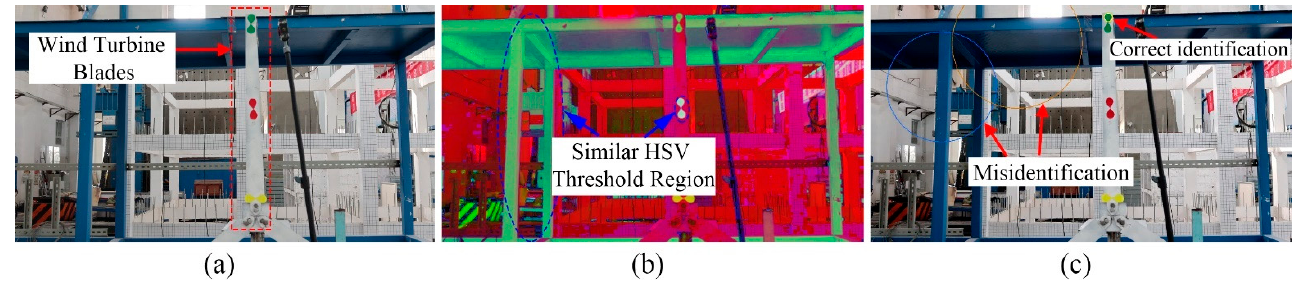
Figure 16. Monitoring effect of optical flow method in a complex background situation: ( a ) Harris corner matching in ROI area; ( b ) actual monitoring effect of optical flow method in ROI area. Figure 14 shows the performance of the three algorithms in the tracking process under the condition of illumination change. When the illumination changes, the prede- termined threshold of the monitoring points exceeds the range, and the color matching algorithm cannot capture the target points. Figure 14a shows the tracking situation of the color matching algorithm at different frame numbers. It can be seen that the color matching algorithm cannot track the monitoring target as long as the illumination changes occur, such as the 800th, 810th and 820th frames. The color matching algorithm is particularly sensitive to illumination changing and cannot track the object when the illumination changes. The optical flow method and the target-free DSST algorithm are not sensitive to illumination when tracking, so they can both accurately capture the tar- get point.